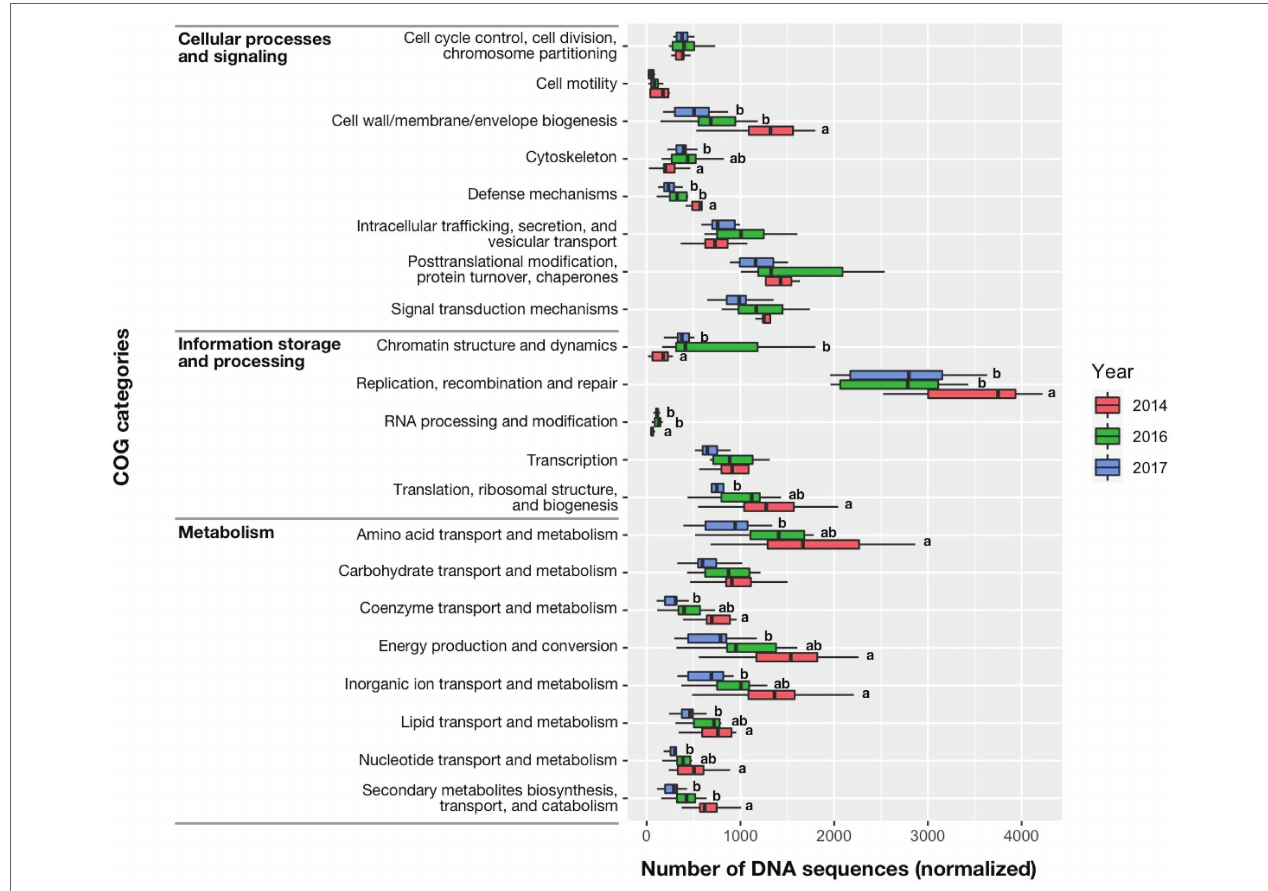
FIGURE 9 | Median (bar), 25th and 75th confidence intervals (box), and maximum and minimum (whiskers) of DNA sequence counts in the clusters of orthologous groups (COG) of proteins database for cell functions of prokaryotes and eukaryotes. Significant differences among years were identified with a Kruskal-Wallis Rank Sum Test, followed by a pairwise comparison using a Wilcoxon Rank Sum Exact Test. Significant differences between years (<0.05 level of significance) were indicated by different letter